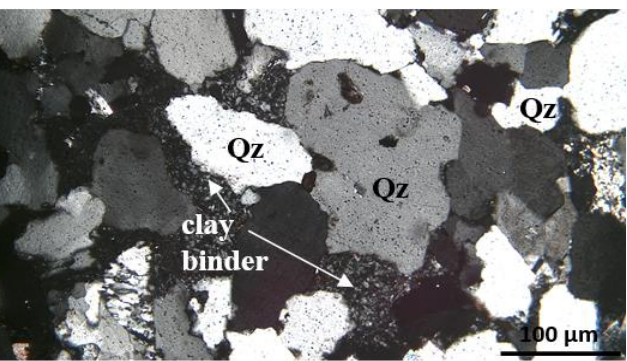
Figure 14. Quartz grains (Q z ) surrounded by clay binder: crossed polars—100× magnification. Carbonates, like clay minerals, could occur in the form of microcrystalline aggregates or single, larger grains characterized by rhombohedral cleavage and variable relief (Figure 7).